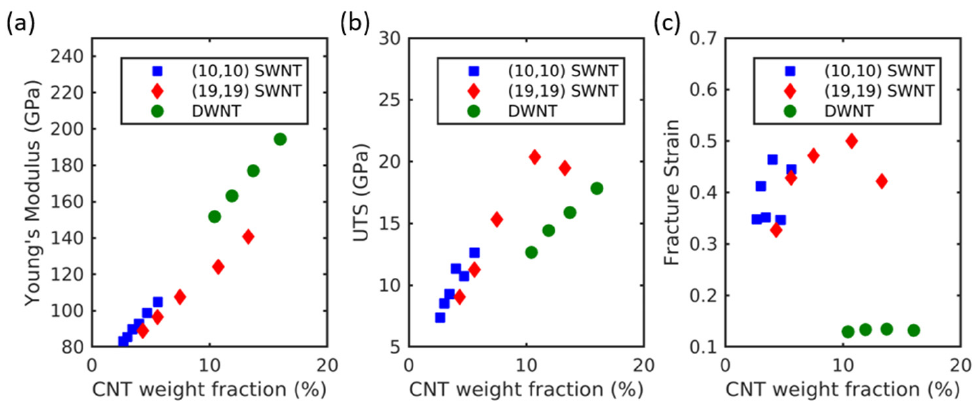
Figure 4. ( a ) Young’s modulus, ( b ) ultimate tensile strength, and ( c ) fracture strain of CNT-Al composites with the variation of the CNT weight fraction.